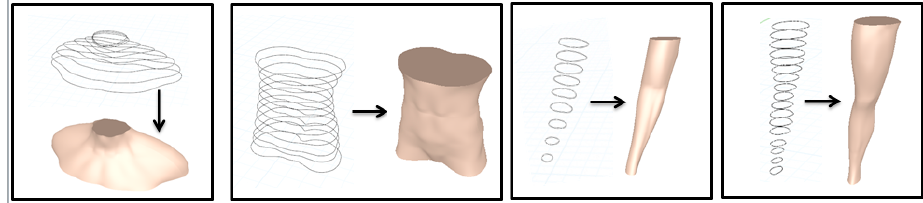
Figure 5. The cross section curves and created human body parts.